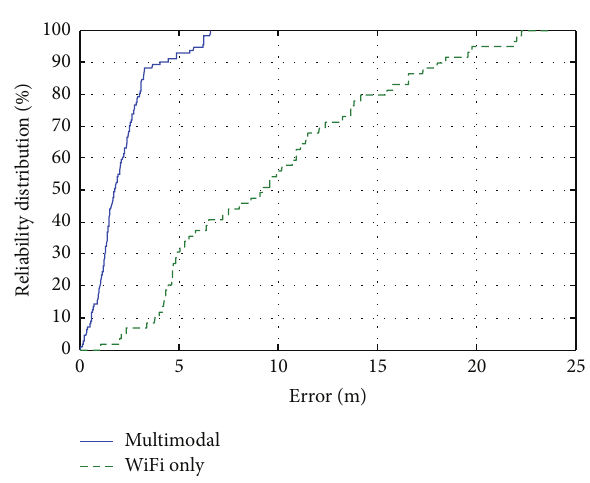
Figure 9: Localization reliability